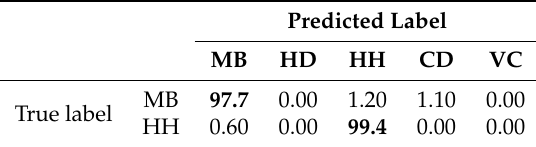
Table 6. Confusion matrix for type classification results (%) against the new inter-floor noise